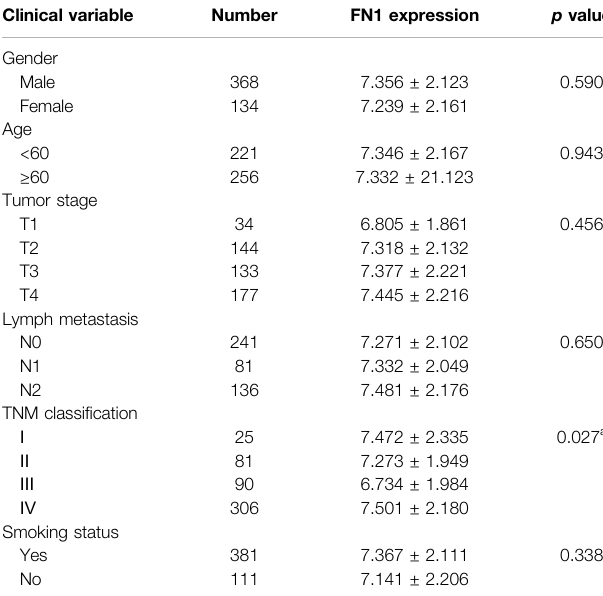
TABLE 1 | Association between FN1 expression and clinical variables in HNSCC patients. Clinical variable